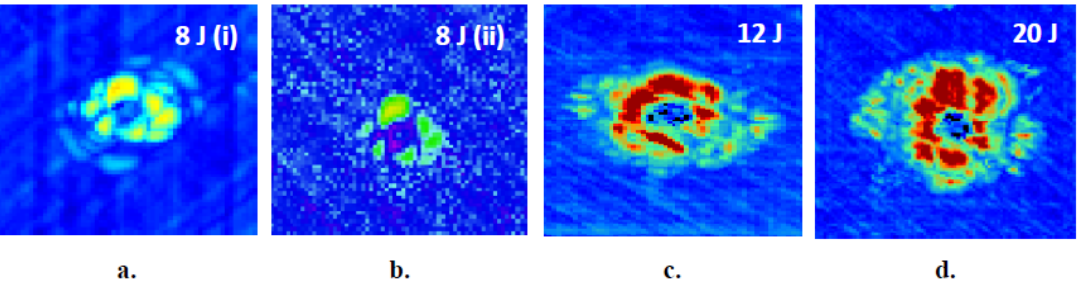
Figure 9. Ultrasonic C-Scan images in thick, 9-layer composite laminates for different levels of impact energies. ( a ) 8 J, ( b ) 8 J, ( c ) 12 J, ( d ) 20 J.